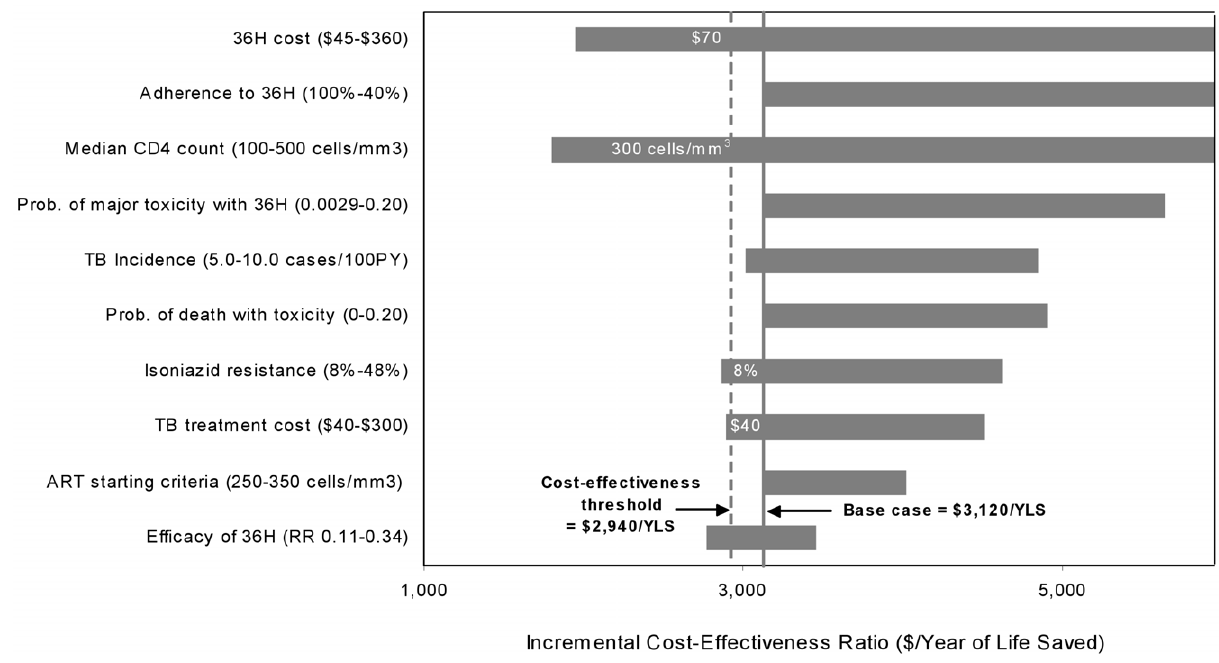
Figure 3. Tornado diagram of one-way sensitivity analyses comparing the 36H regimen to the 6EH regimen . Selected model parameters are listed on the vertical axis, with the range examined in sensitivity analyses listed in parentheses. The horizontal axis demonstrates the impact of changes in the parameter values on the incremental cost-effectiveness ratios for the 36H regimen compared to 6EH regimen. The solid vertical line indicates the incremental cost-effectiveness ratio estimate ( $ 3,120/YLS) of the base case, and the dashed vertical line indicates the suggested cost-effectiveness threshold ratio of $ 2,940/YLS (3x GDP India). Values in white in the center of the bars indicate the threshold value of each parameter at which the cost-effectiveness ratio for 36H compared to 6EH is equal to $ 2,940/YLS. For example, a total cost of $ 90 for the 36H regimen was assumed in the base case. The incremental cost-effectiveness ratio of 36H compared to 6EH was less than or equal to $ 2,940/YLS (i.e. cost-effective by international standards) when the cost of 36H was less than $ 70. 36H: Thirty-six-month regime of isoniazid, 6EH : Six-month